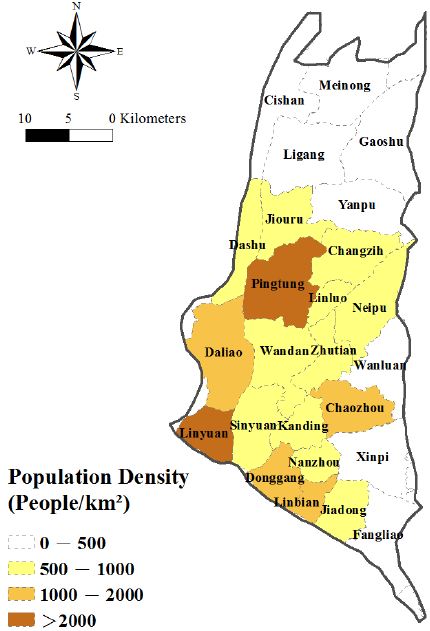
Figure 2. Population densities of townships in the study area.